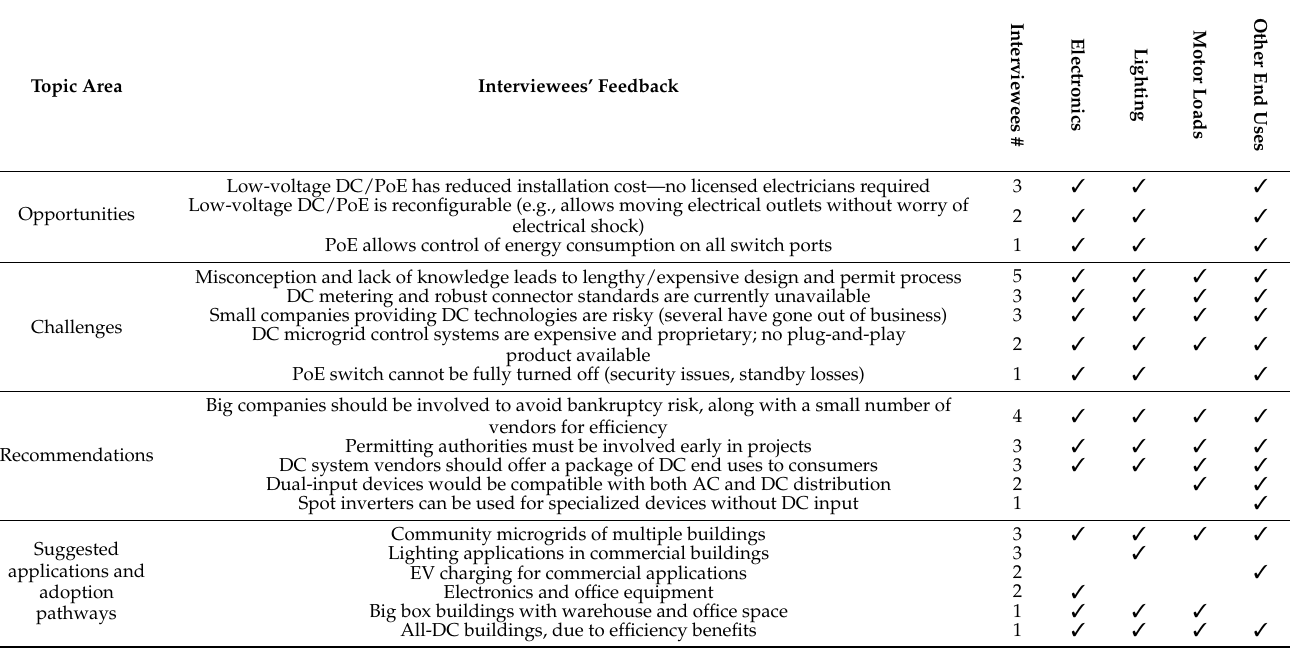
Table 5. Summary of expert elicitation